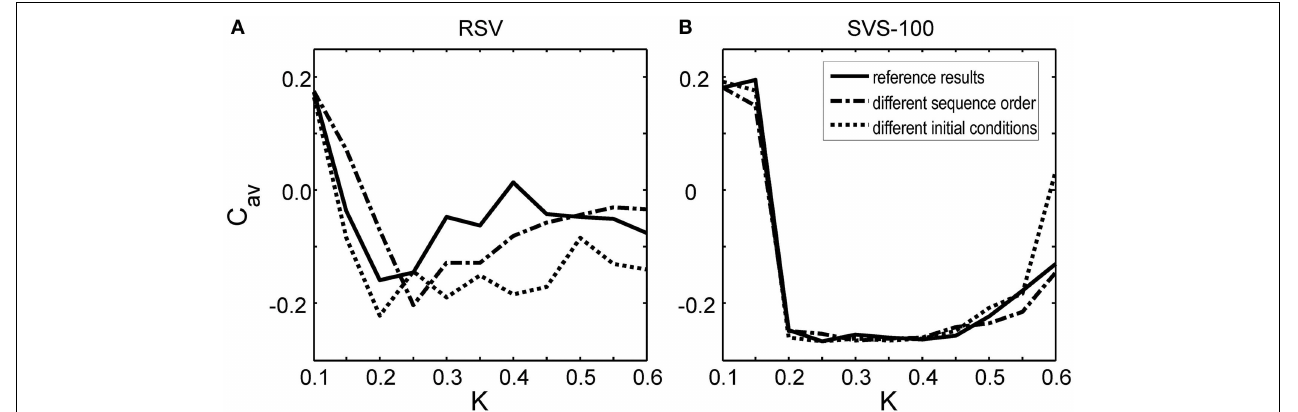
this Figure. The dashed-dotted lines show the result for a simulation with the same initial network conditions as used to obtain the reference results but for another randomly chosen sequence order. The dotted lines represent the obtained C av -values at t = 128 s for a simulation with the same sequence order as used to obtain the reference results, but for other initial network conditions.